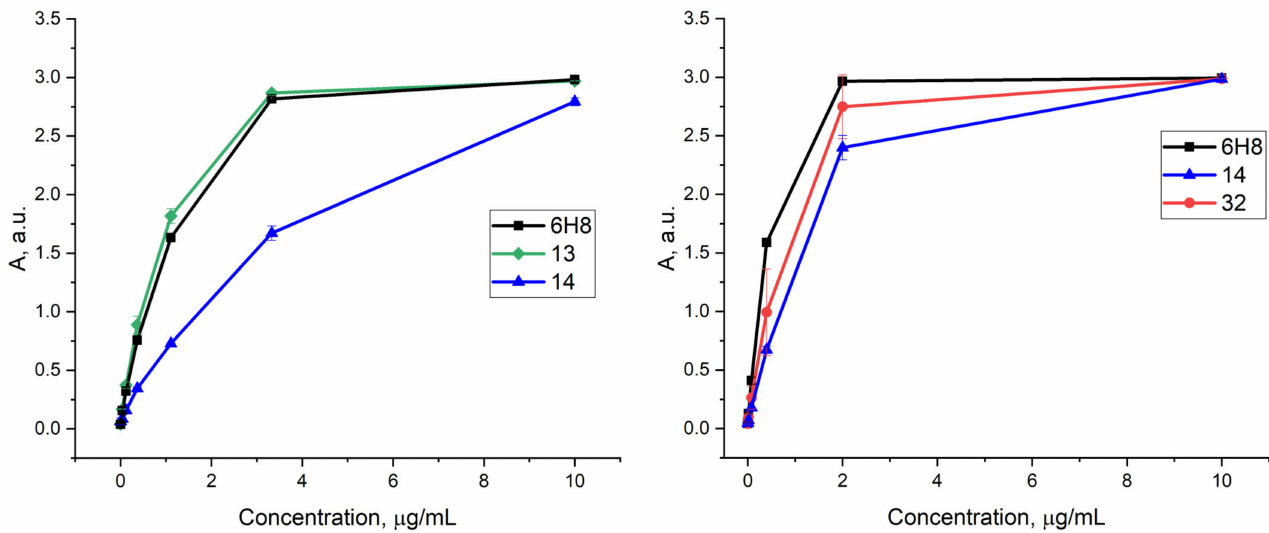
Figure 6. Affinity of conjugates 13 , 14 , and 32 analyzed by